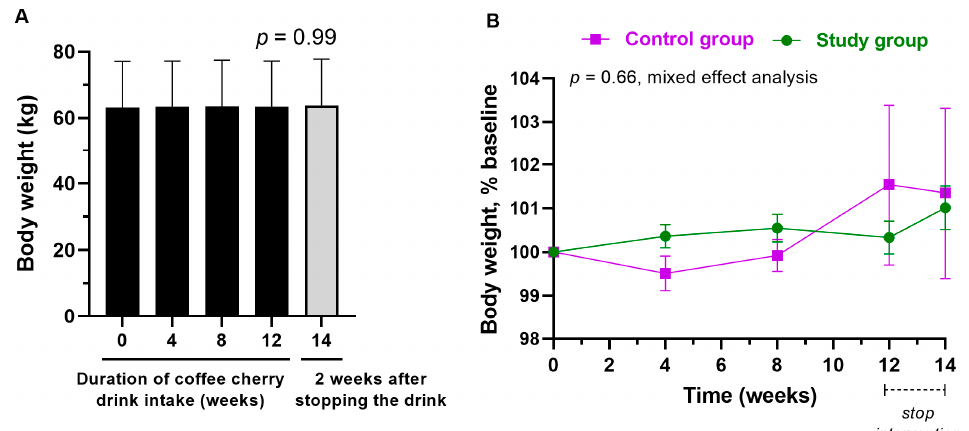
Figure 3. Changes in body weight of the volunteers. ( A ) The bar graph shows the mean and standard